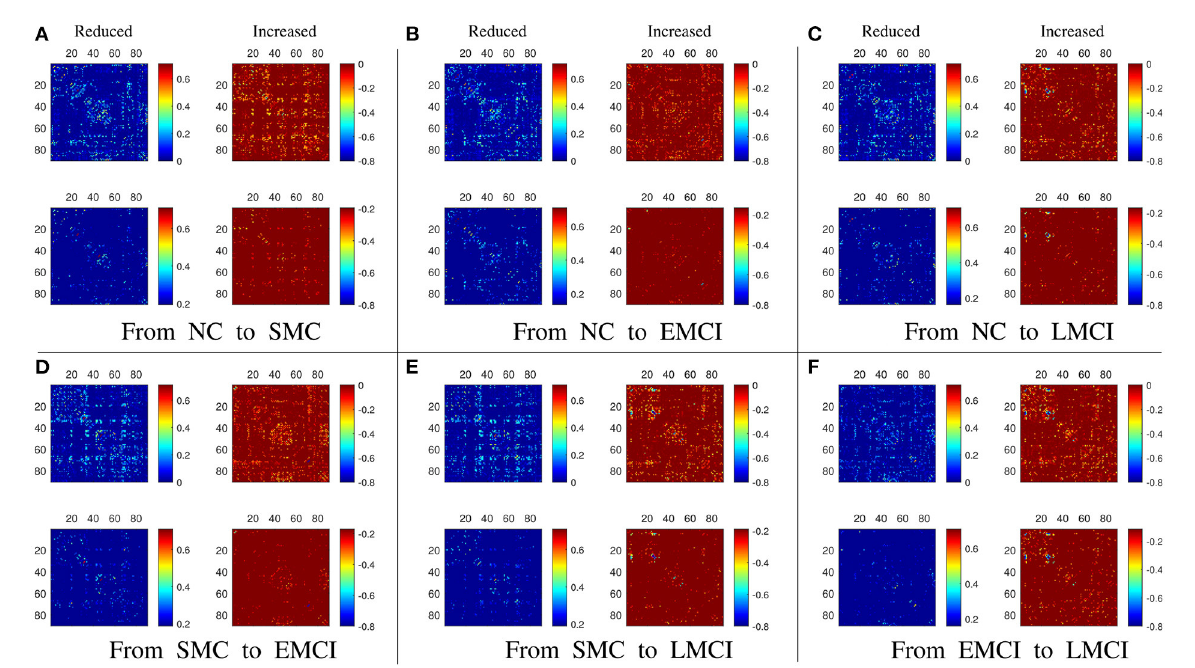
FIGURE8 (A–F) The results of the altered functional connectivity estimated from the averaged BFNs between different groups (i.e., NC vs. SMC, NC vs. EMCI, NC vs. LMCI, SMC vs. EMCI, SMC vs. LMCI, EMCI vs. LMCI). In each subfigure, the upper row means the reduced and increased connections, the lower row shows the altered connections selected from the upper row with a threshold of 90 % quantile value.